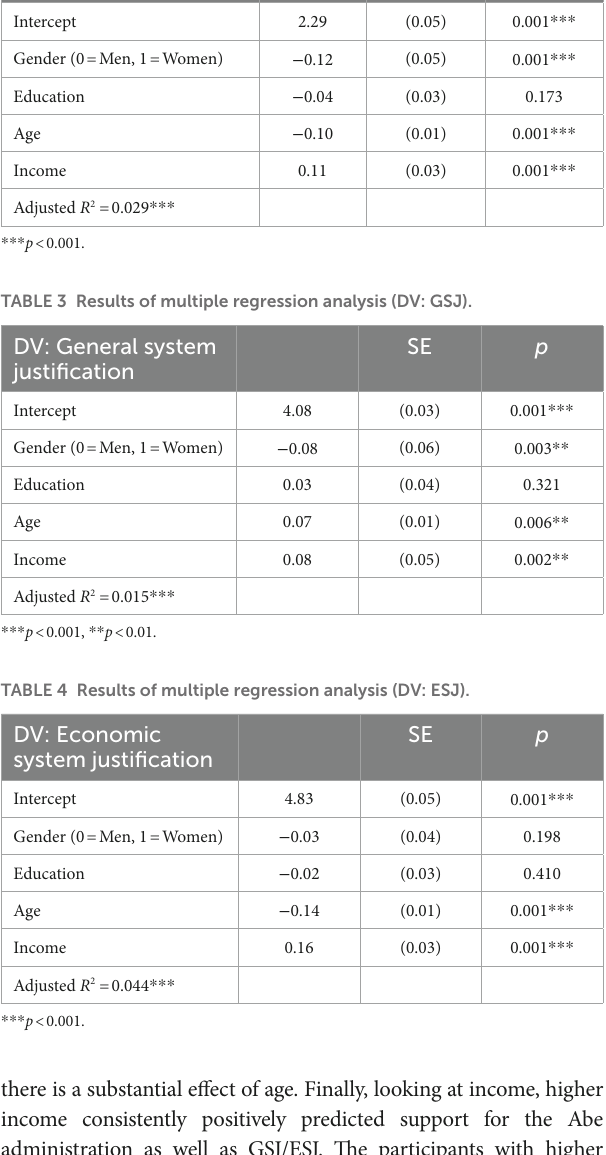
TABLE 2 Results of multiple regression analysis (DV: Support for the Abe administration). DV: Support for the Abe administration